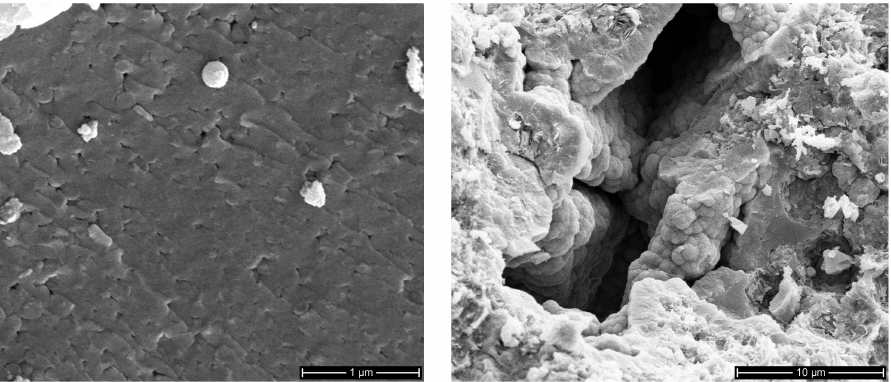
Figure 6. SEM images of freshly ground G34280 (opal-AG from Cerenvenica, Slovakia) showing mixed